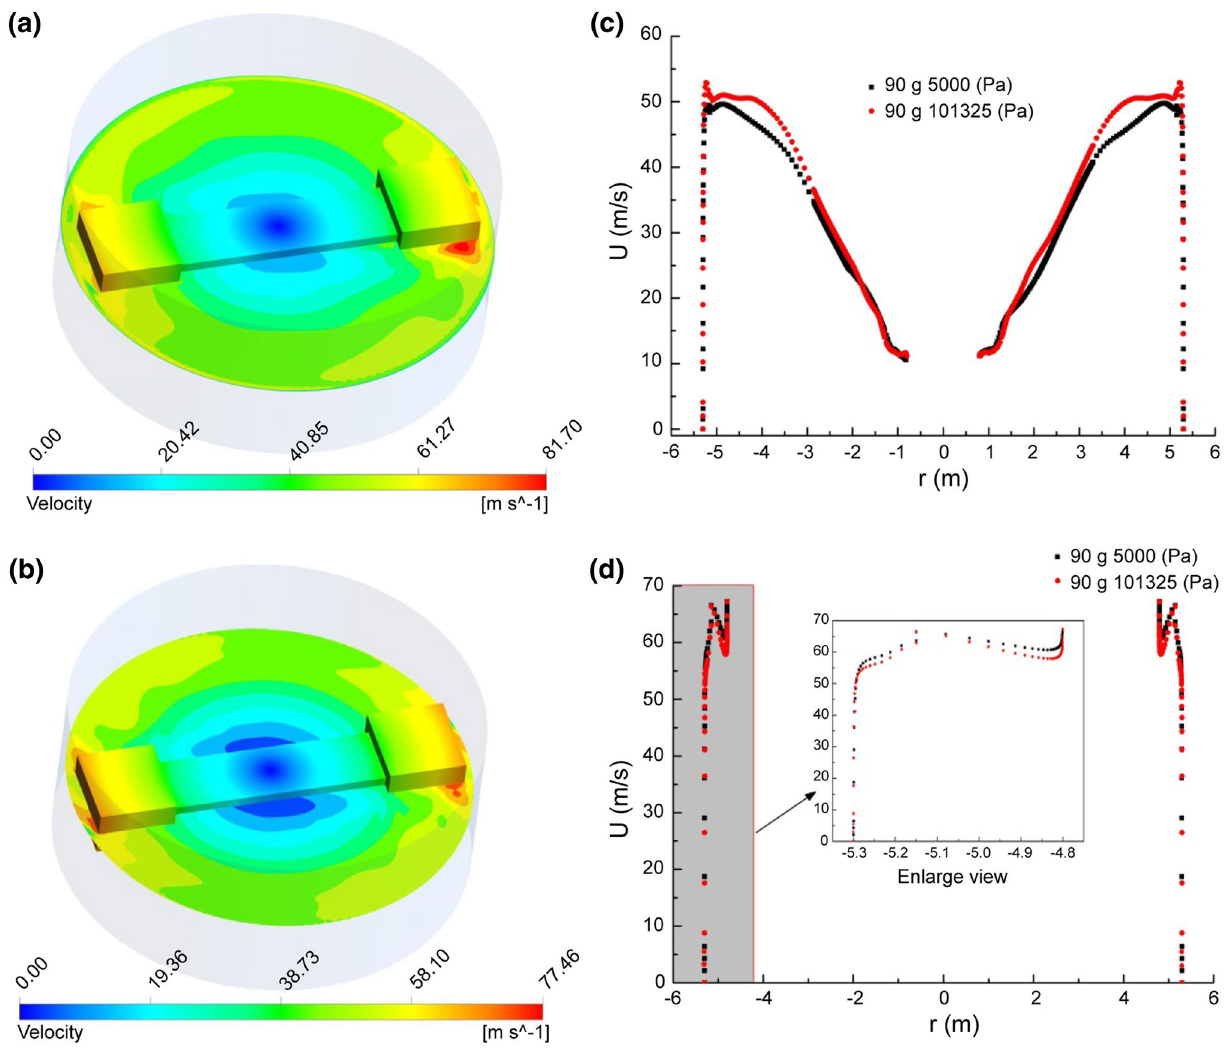
Fig. 11 Velocity cloud image of the A–A cross-section at a 5,000 Pa and b atmospheric pressure. Lines c one and d two velocity comparison